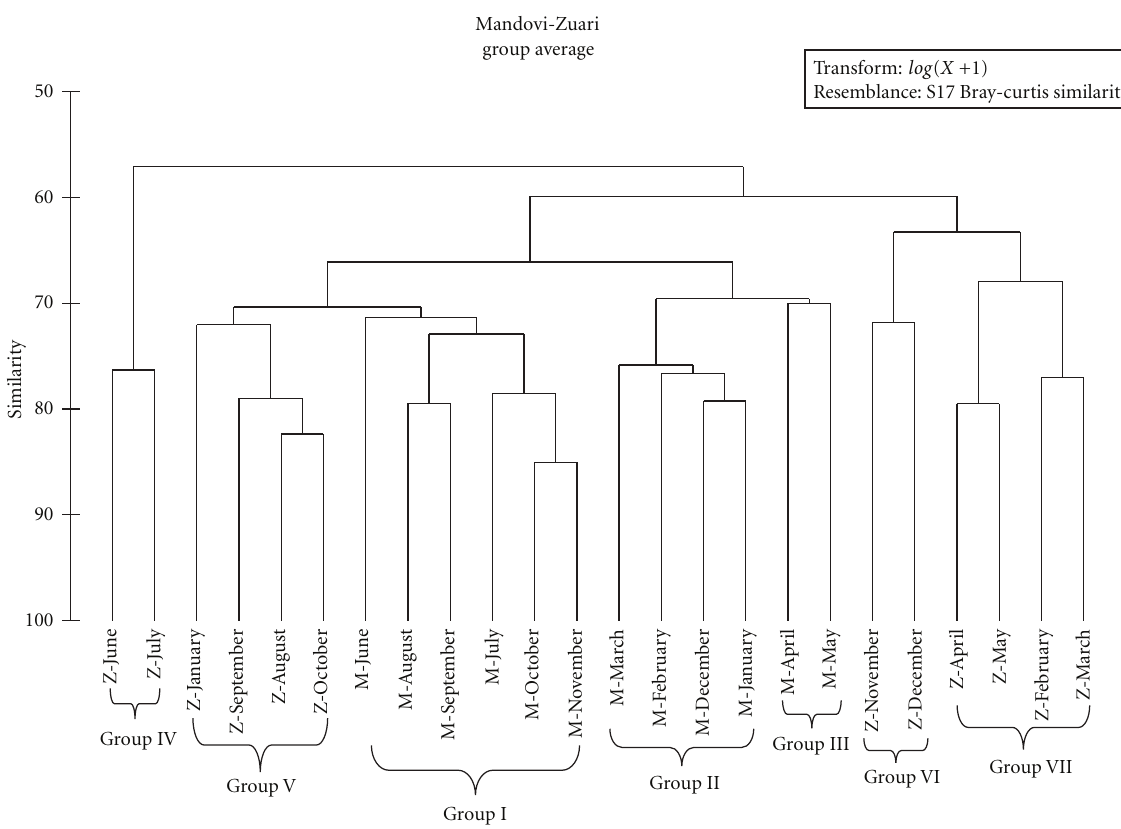
Figure 4: Dendrogram of cluster analysis based on Bray-Curtis similarity index in both the estuaries.